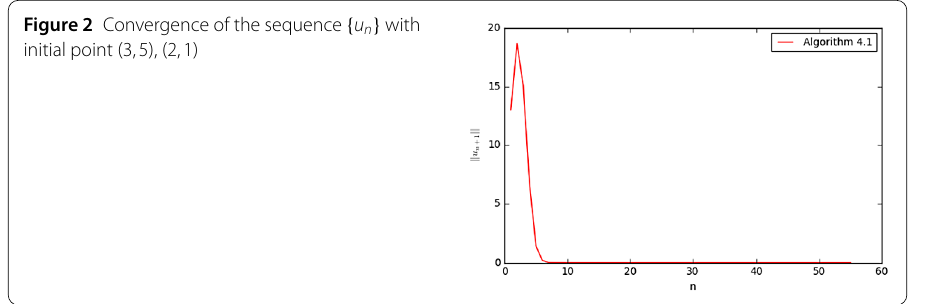
Figure 2 Convergence of the sequence { u n } with initial point (3,5), (2,1)